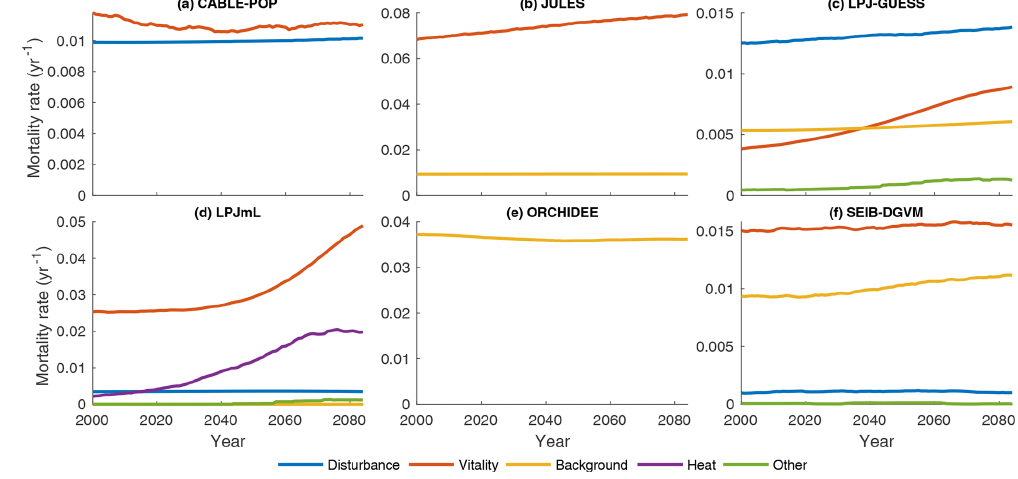
Figure 9. Mortality rate ( F turn /C veg ) for the needleleaf evergreen forest type split by conceptual process grouping (Table 3) for the period 1985–2099 in the simulation forced by IPSL-CM5A-LR RCP8.5 bias-corrected climate data. Observational forest types were used. For clarity, 31-year running means are plotted, and thus only 2000–2085 is shown. No process breakdown was available for ORCHIDEE; hence all processes were designated as background. Note y scales differ between